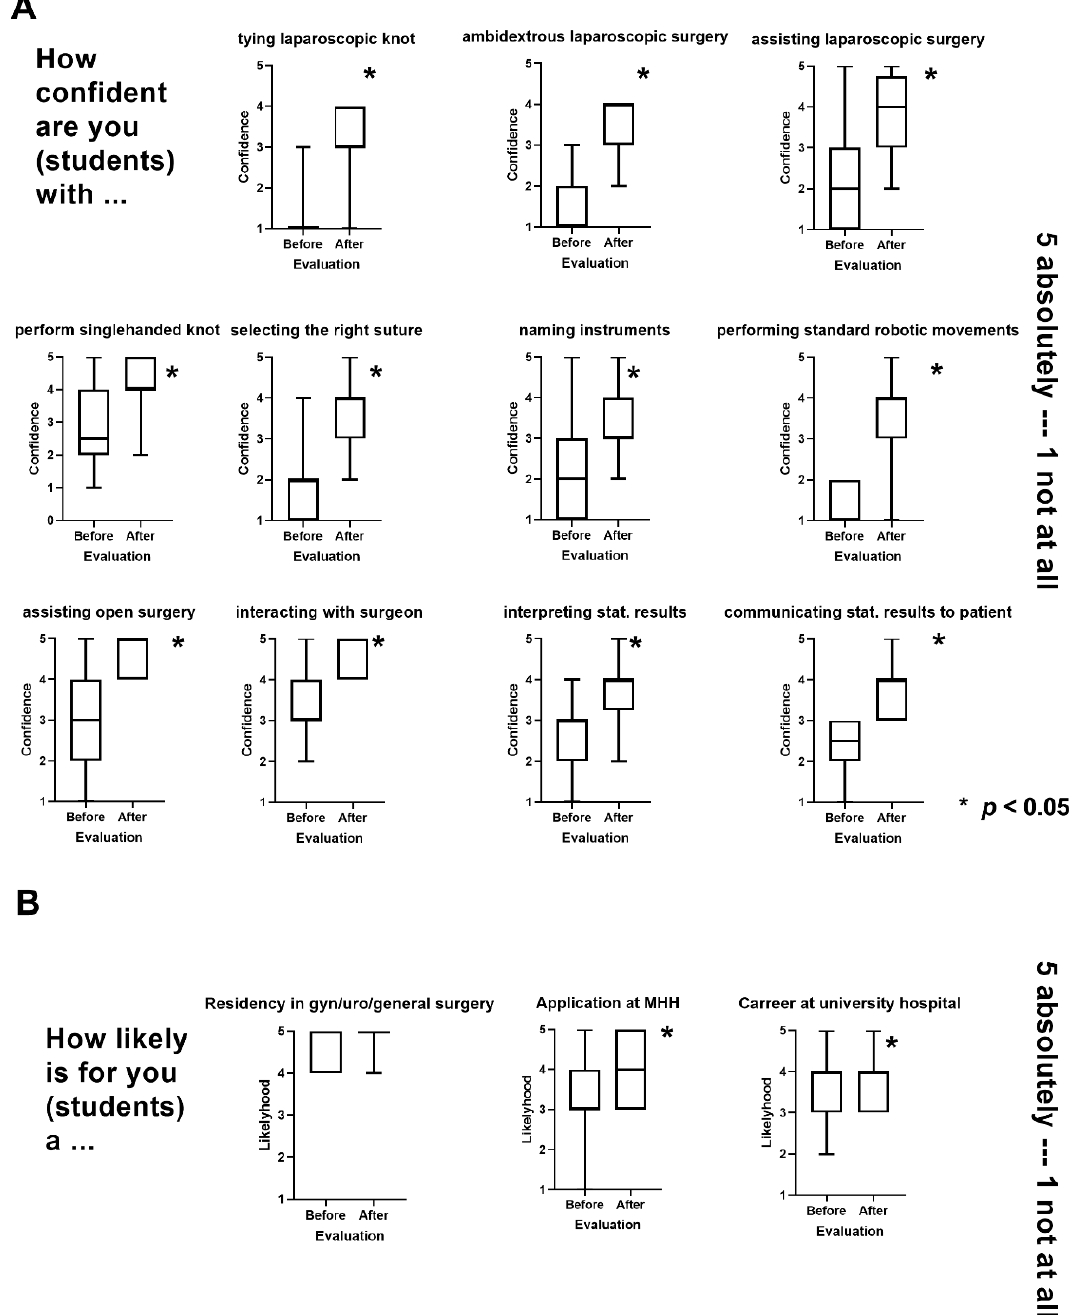
Figure 2. ( A ) Evaluation of the participants’ confidence in different dimensions that should be improved by SOCIUS mentoring. ( B ) Future career plans of students. Boxplots of the values before and after participation in the SOCIUS program are shown. Scoring was on a scale from 1 (lowest agreement) to 5 (highest agreement). MHH = Hannover Medical School; gyn = gynecological, uro = urological .